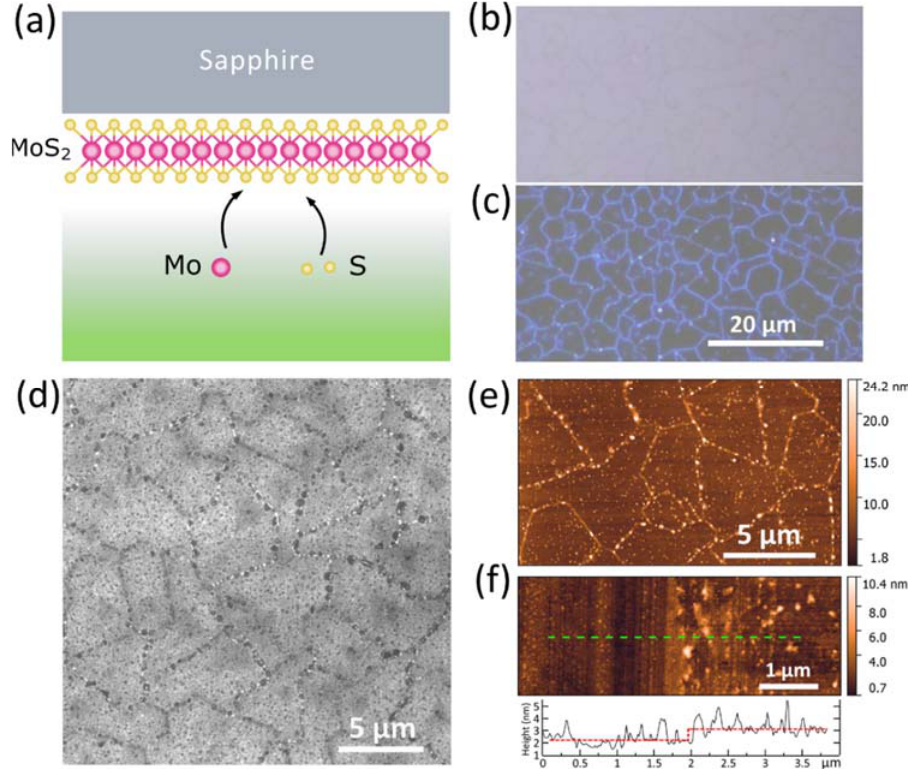
Figure 1. ( a ) A schematic diagram showing the concept of MBE growth monolayer MoS 2 on a sapphire substrate. ( b , c ) Optical image of the epitaxial MoS 2 taken in bright field ( b ) and dark field ( c ) regimes. MoS 2 covers more than 97% of the surface. ( d ) SEM image of the epitaxial MoS 2 revealing the high crystallinity of the samples with the characteristic crystallite size 6 ± 2 μ m. ( e ) The AFM topography map of MoS 2 surface with a scan area of 17.5 × 10 μ m 2 . Root mean square roughness of MoS 2 is 0.5 nm in areas without defects. ( f ) The AFM topography map and the cross-sectional profile of the edge of epitaxial MoS 2 along the green line, giving the MoS 2 layer thickness of ~0.9 nm. The scan area was 5.5 × 2 μ m 2 .